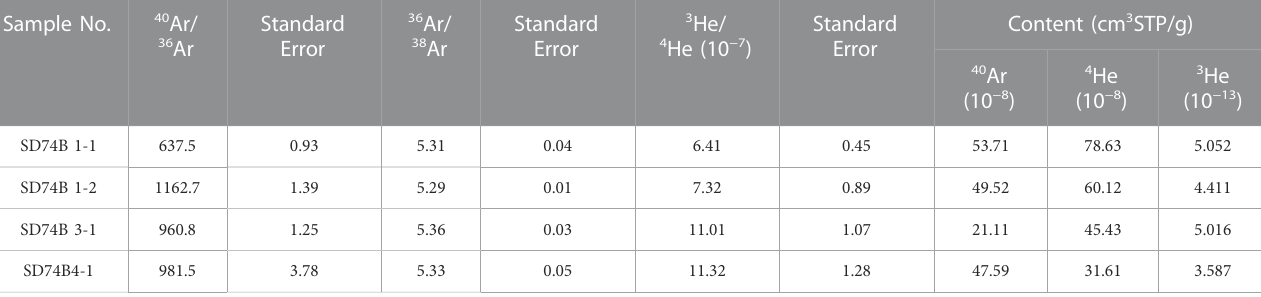
TABLE 2 He and Ar isotopic compositions of fl uid inclusions in pyrites from the Yangjiakuang gold deposit. Sample No.